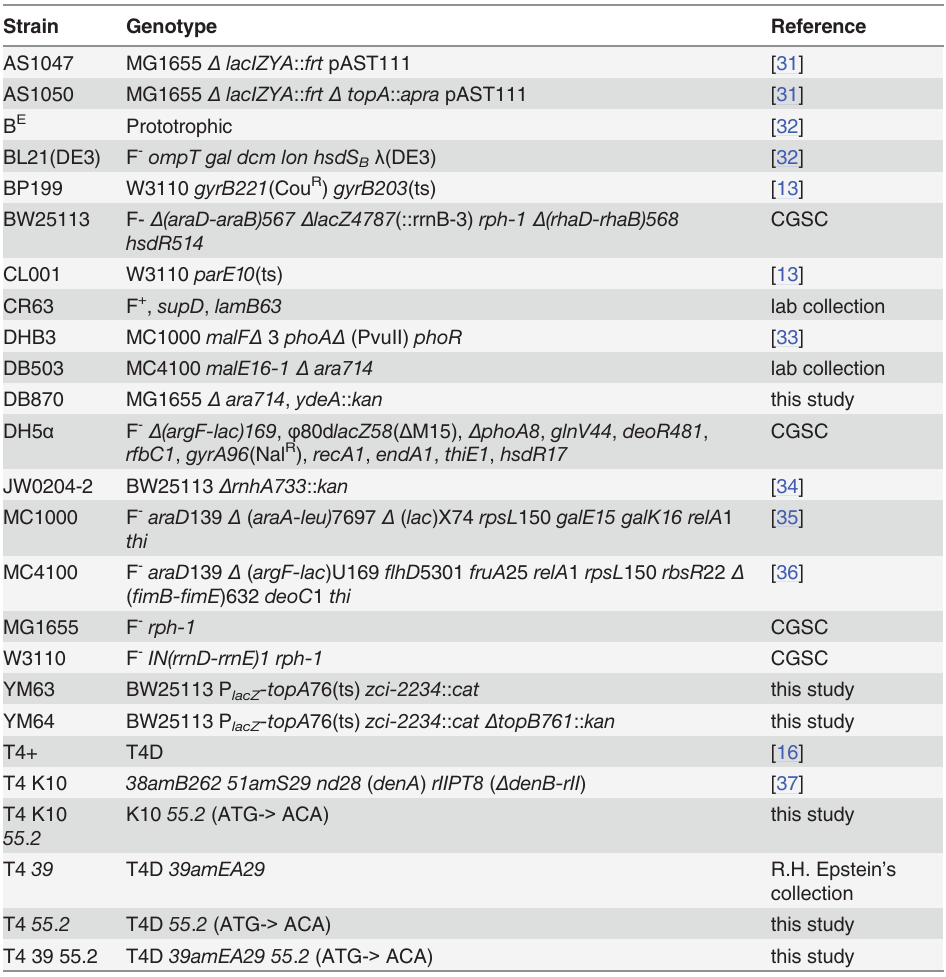
Table 1. E. coli a and T4